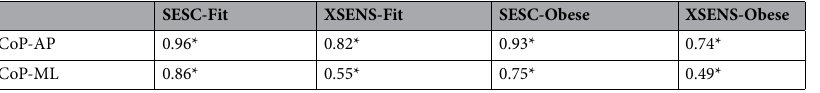
Table 3. Pearson correlation coefficients for the CoP measurements and CoM estimations by SESC and XSENS for Fit and Obese groups along the AP and ML axes (Significant correlations ( p < 0.001) are indicated by *).